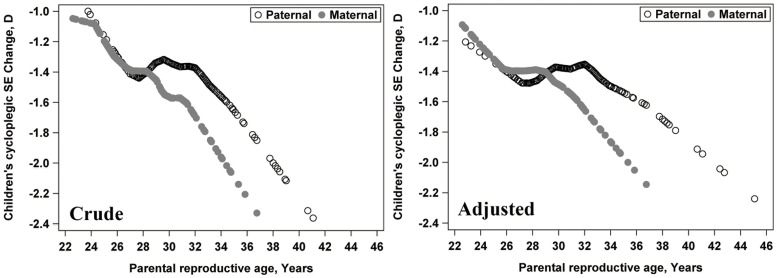
The relationship between the children’s cycloplegic spherical equivalent (SE) change and paternal/maternal reproductive age in all children using the multivariate LOESS regression model.Left, unadjusted; Right, father: adjusted for children's age, baseline cycloplegic SE, paternal non-cycloplegic SE, and near work time; mother: adjusted for children's age, baseline cycloplegic SE, maternal non-cycloplegic SE, and near work time.